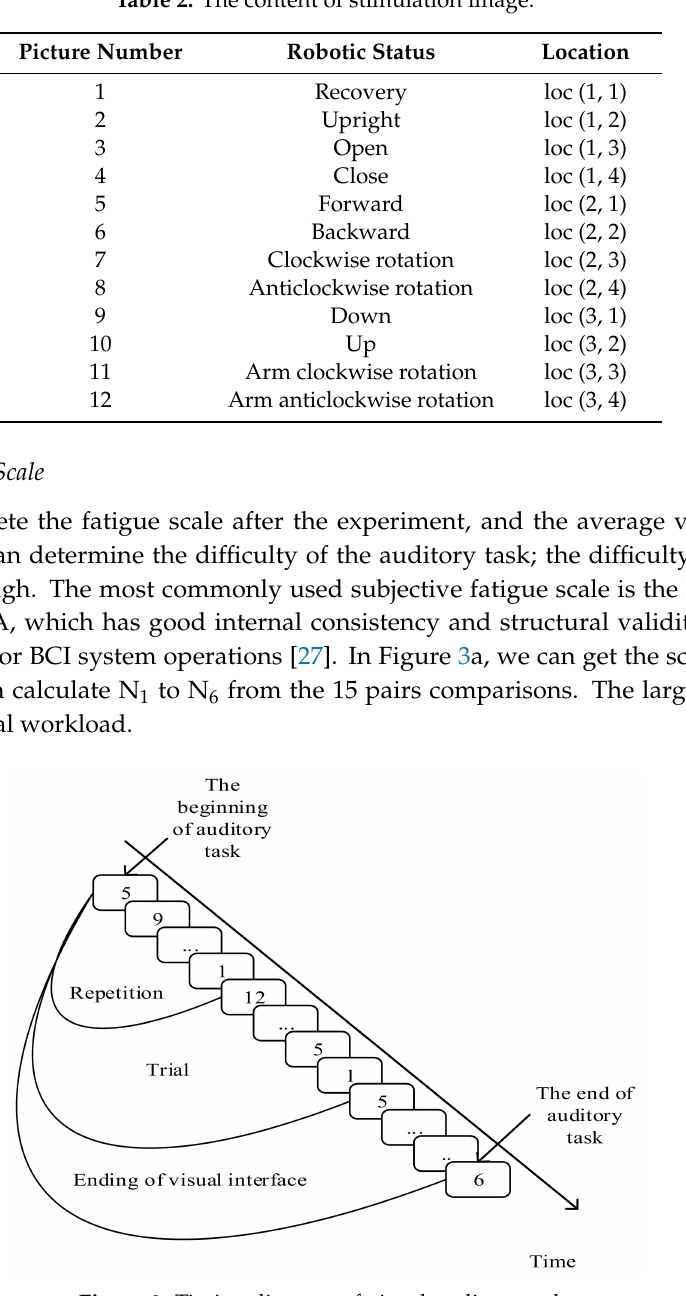
Figure 2. Timing diagram of visual-auditory